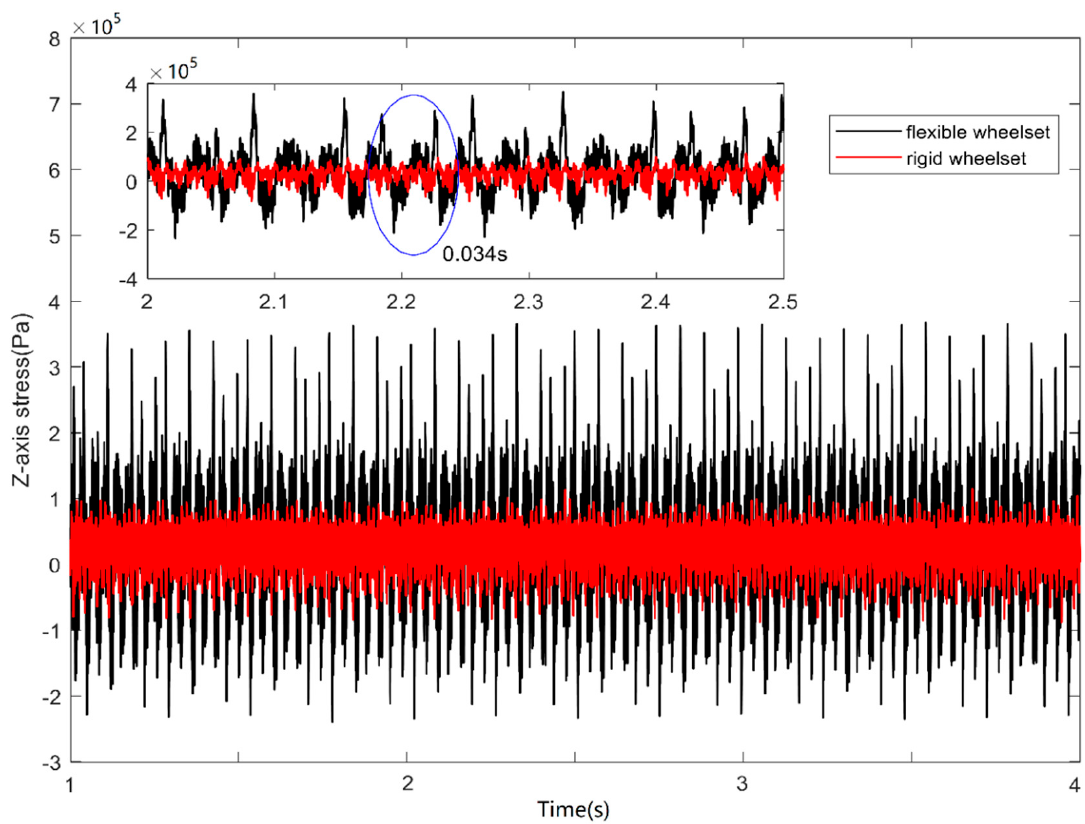
Figure 17. Effect of wheelset elastic deformation on dynamic stress of gearbox.